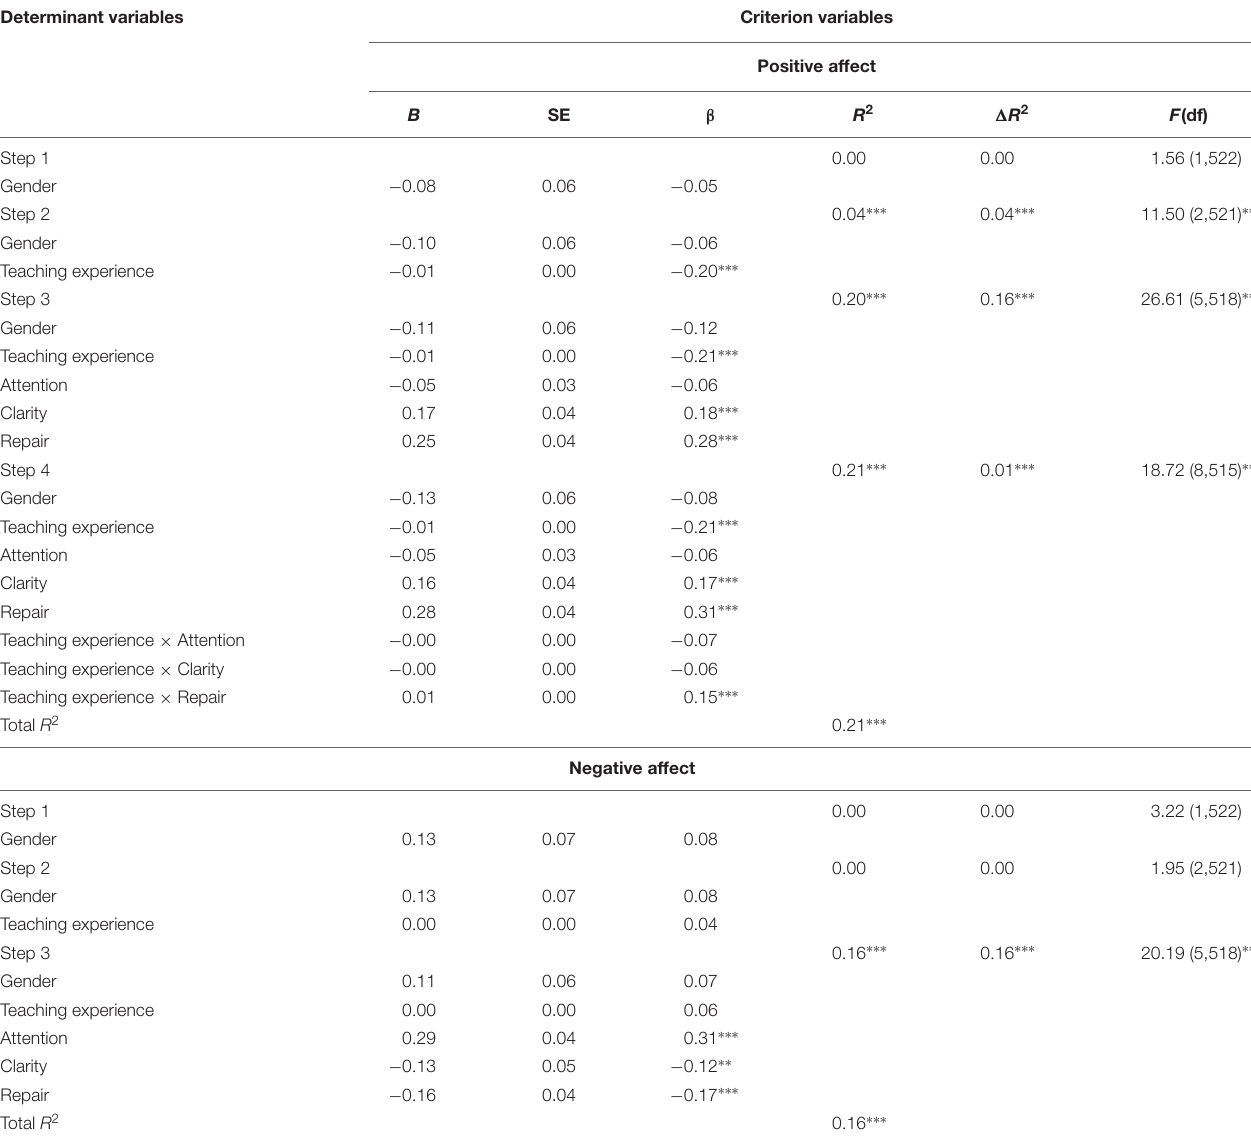
TABLE 2 | Hierarchical regression to determine teachers’ affective well-being on the basis of teaching experience and perceived emotional intelligence (EI). Determinant